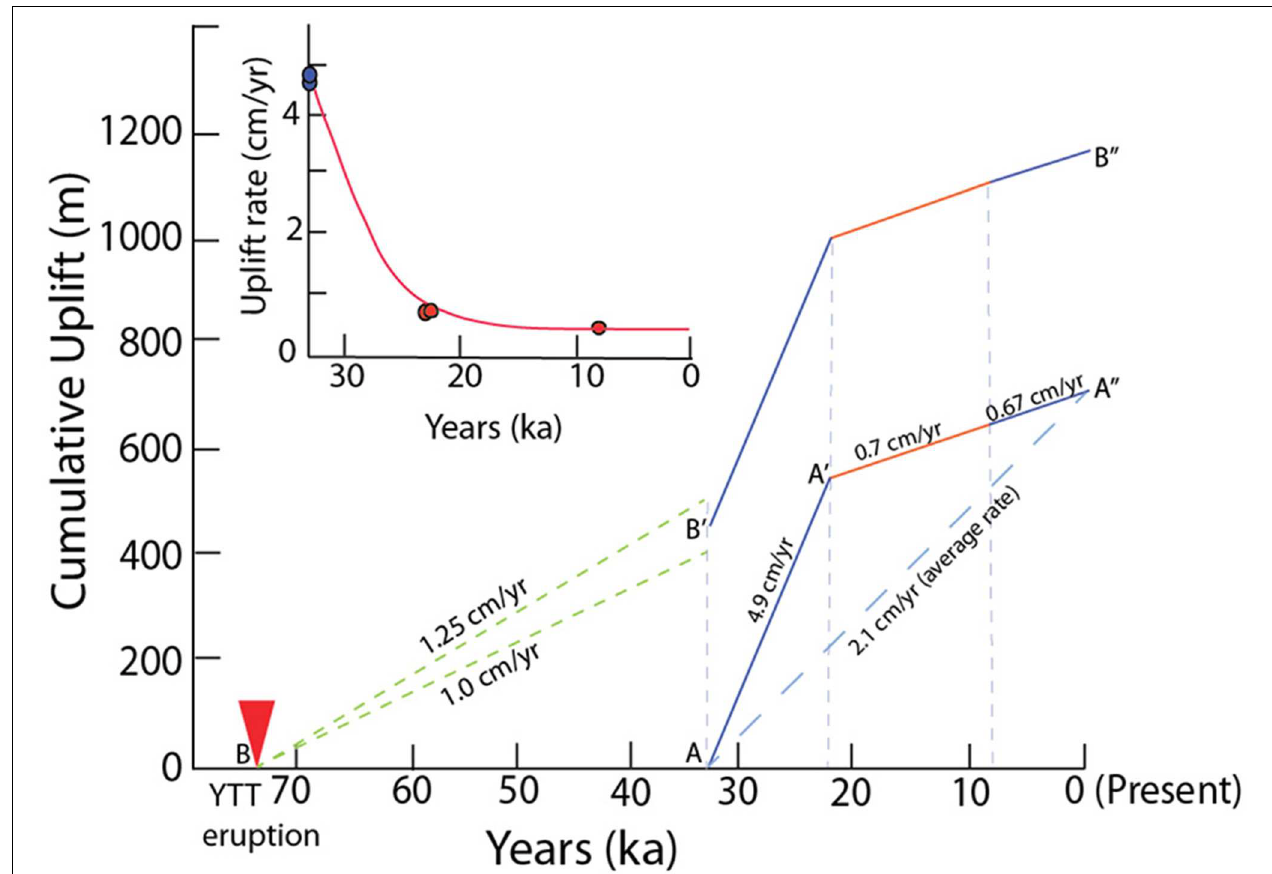
FIGURE 6 | Representation of the various uplift parameters calculated for Samosir. The main figure shows cumulative uplift (elevation gain with time) of the eastern scarp of Samosir based on 14 C age determinations and current elevation above lake level datum ∼ 900m. A–A–A ′′ represents the C 14 data constrained cumulative uplift path defined by samples (Toba 2,3,4, and 5 on Figure 4 ). The dashed blue line connecting A–A ′′ is the average rate based on the elevation and age of the highest ( ∼ 1600m) sediment on Samosir. B–B ′ –B ′′ is the cumulative uplift